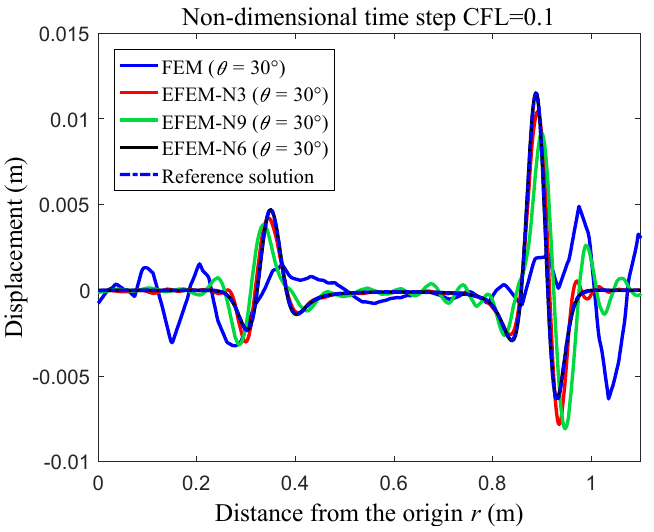
Figure 14. The displacement distribution responses of the membrane with holes from various numerical techniques when the considered time point t = 1 s.